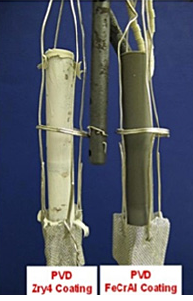
Fig. 8. Mo tubes with both-ends welded to endcaps and coated with either FeCrAl or Zircaloy-4 after testing in 1000 ° C steam for 7 days.